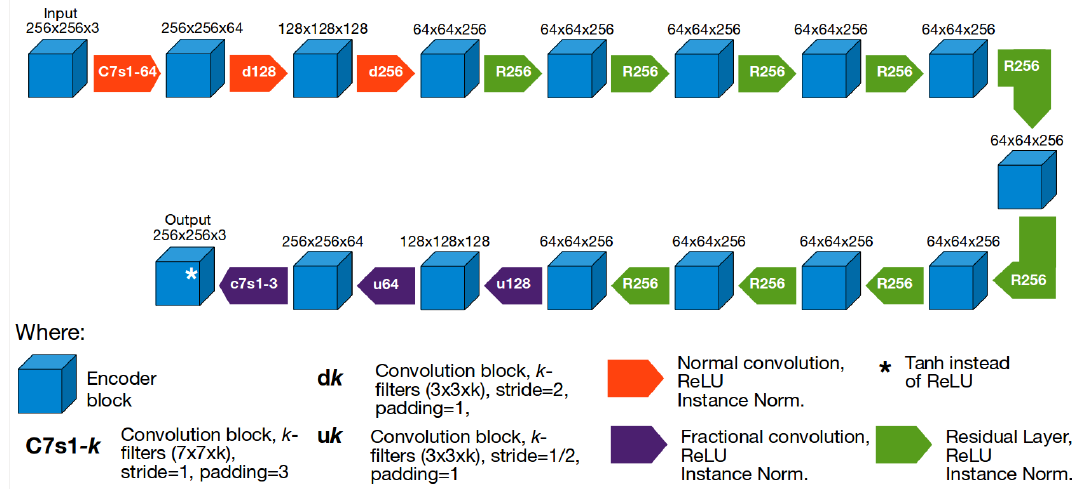
Figure 2. Architecture of